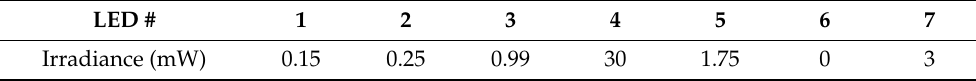
Table 4. Evaluated irradiance on the sensors using the UV LEDs from the calibrator circuit. LED #